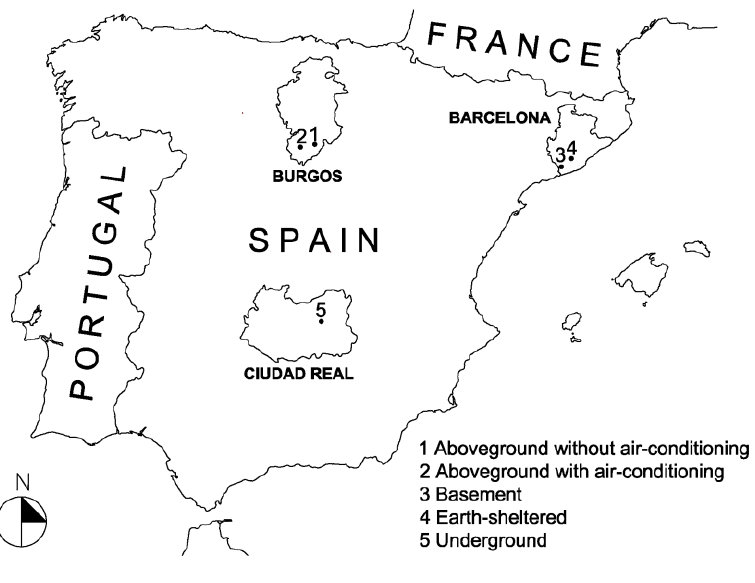
Figure 1. Location of the five monitored